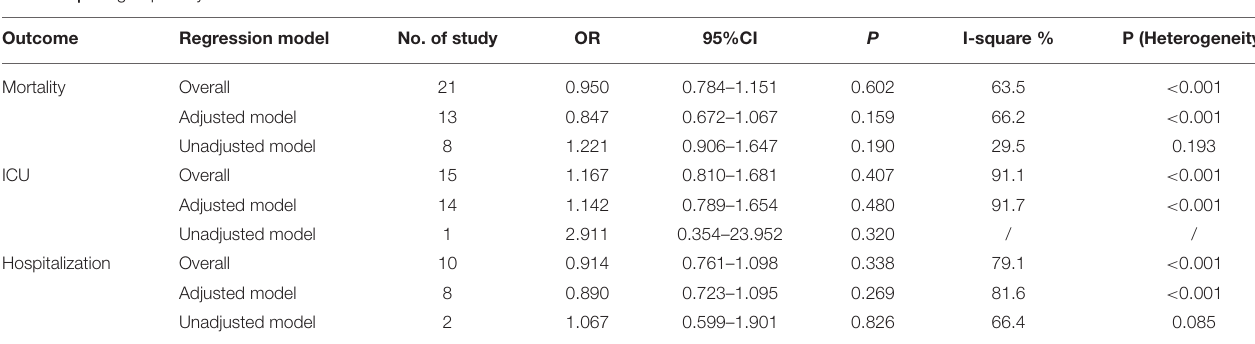
FIGURE 2 | Forest plot of mortality comparing patients with or without preexisting asthma by the model applied. Weights and between-subgroup heterogeneity test are from random-effects model. TABLE 1 | Subgroup analysis: treatment vs.